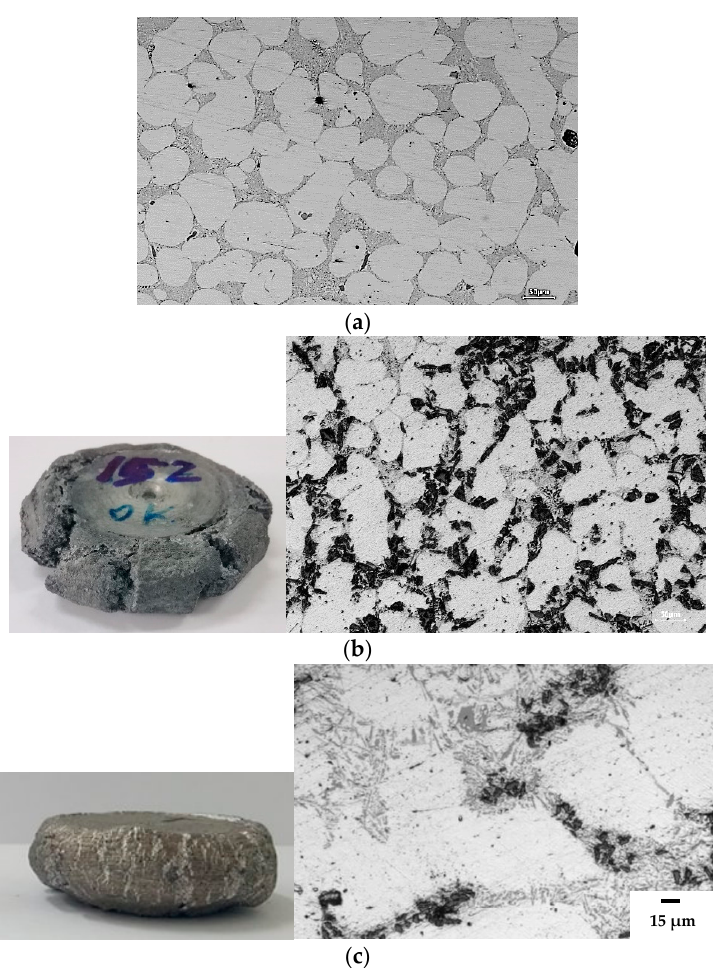
Figure 8. Microstructures after thixoforming of ( a ) A356; ( b ) A356 / SiC feedstock ( 15%SiC - 37µm); and ( c ) A356 / SiC feedstock ( 15%SiC - 15µm ) .